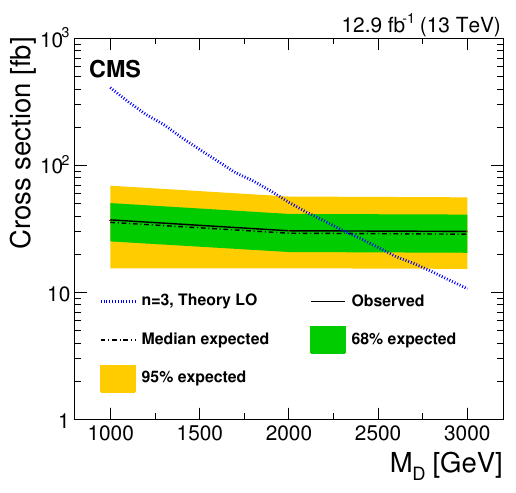
Figure 6 . The 95% CL upper limits on the ADD graviton production cross section, as a function of M D for n = 3 extra dimensions.